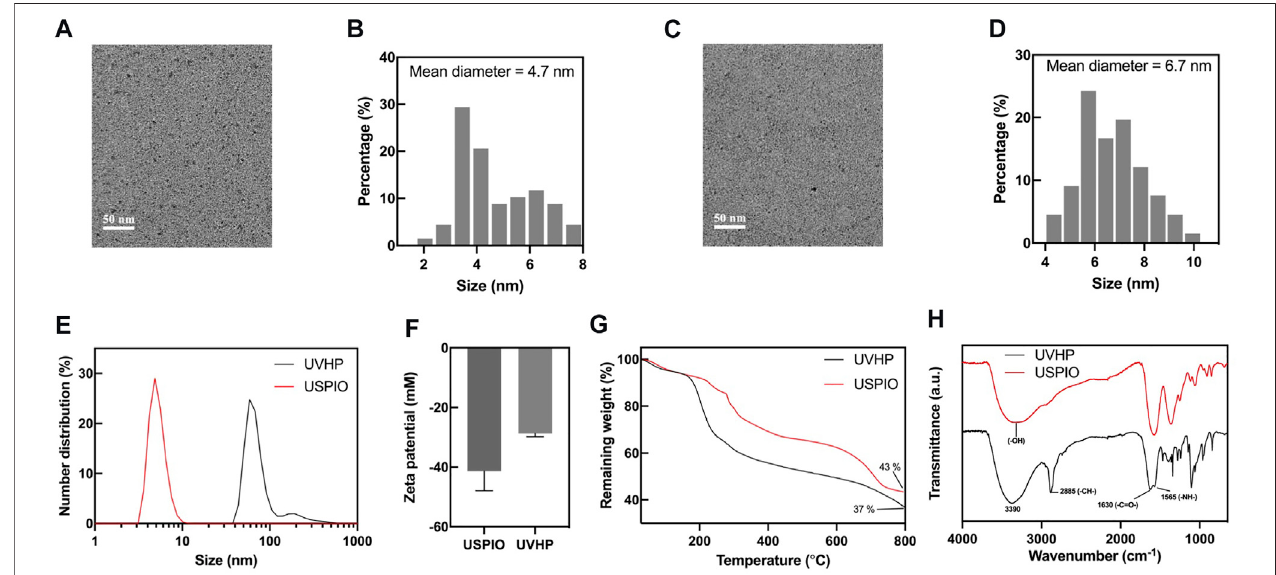
FIGURE 2 | Characterizations of USPIO and UVHP. (A) TEM image of USPIO; (B) size distribution histogram of USPIO; (C) TEM image of UVHP; (D) size distribution histogram ofUVHP; (E) hydrodynamic sizes ofUSPIOand UVHP; (F) zeta potentials ofUSPIO, UVHP; (G) TGA curves ofUSPIO, UVHP; (H) FTIR spectra of USPIO,